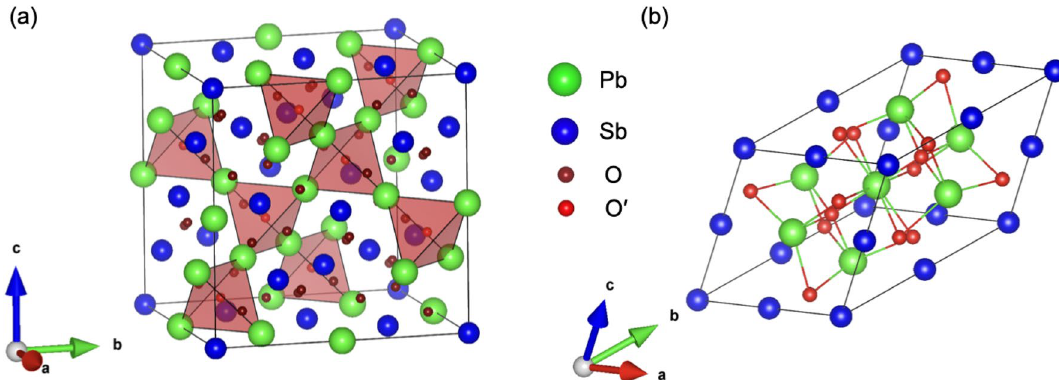
Figure 2. Crystal structure of pyrochlore Pb 2 Sb 2 O 7 for the ( a ) conventional unit cell and ( b ) PUC. A 3D corner-sharing network of Pb 4 O ′ tetrahedra is highlighted. The illustration of the crystal structures was produced using VESTA 43 . The internal atomic positions in the PUC were generated using cif2cell 44